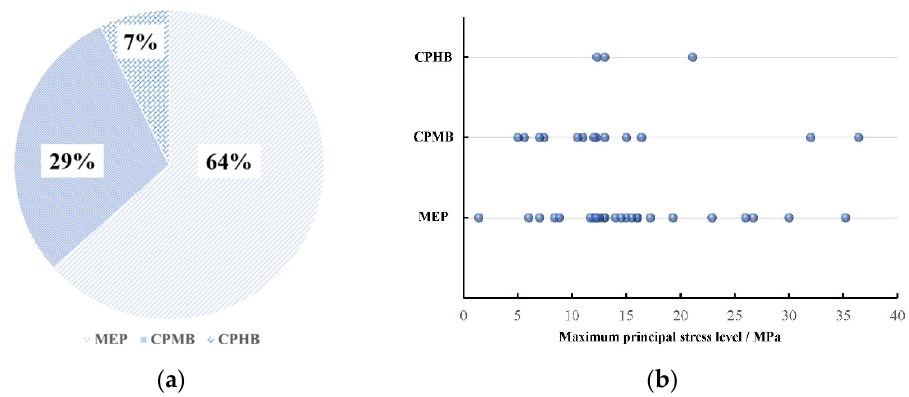
Figure 17. Excavation procedures of the high side wall zone. ( a ) MEP method; ( b ) CPMB method; ( c ) CPHB method.